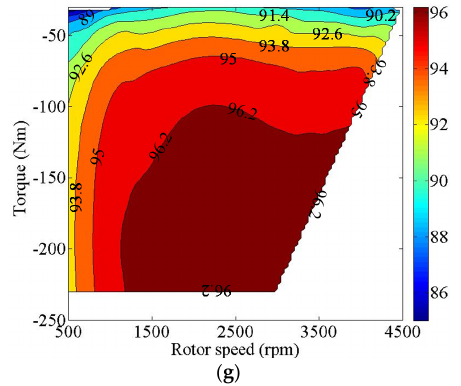
Figure 11. Efficiency maps of two machines. ( a ) Outer FSPM machine in traction mode; ( b ) Outer FSPM machine in generating mode; ( c ) Inner FSPM machine in generating mode; ( d ) Inner machine of the DMP machine in traction mode; ( e ) Inner machine of the DMP machine in generating mode; ( f ) Outer machine of the DMP machine in traction mode; ( g ) Outer machine of the DMP machine in generating mode.